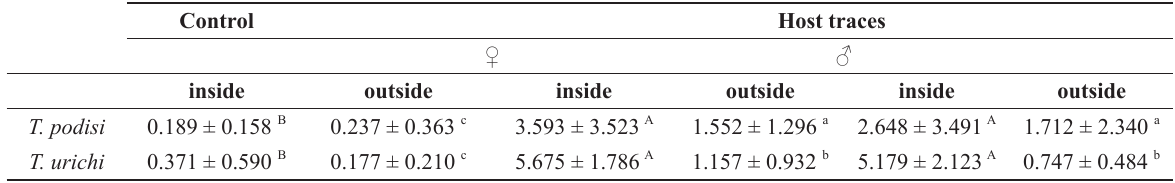
Different letters indicate significant differences in time spent by wasps inside (uppercase) or outside (lowercase) the central circular area, among